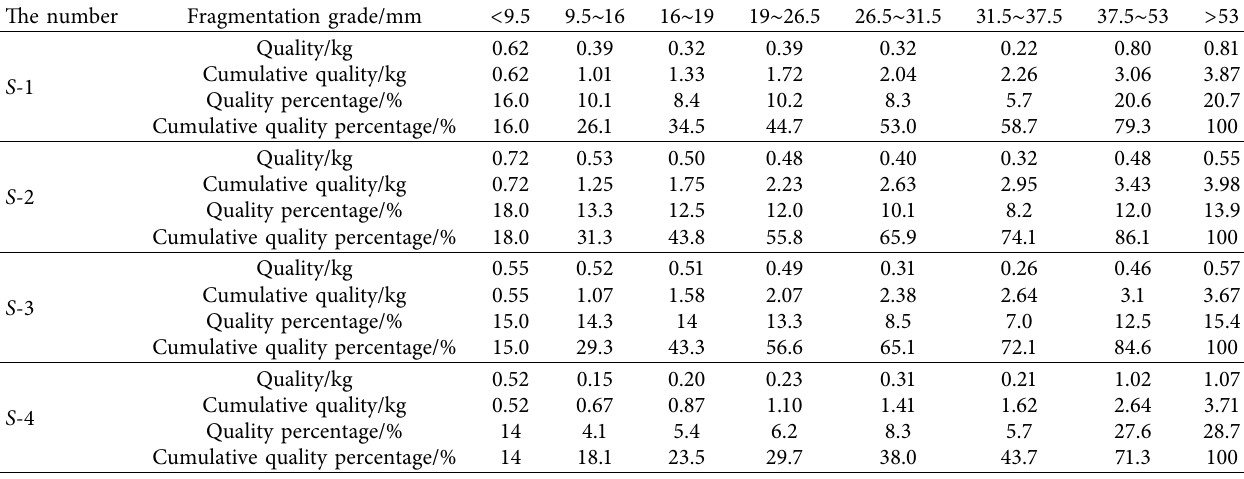
Table 3: Statistical table of blasting fragmentation screening.